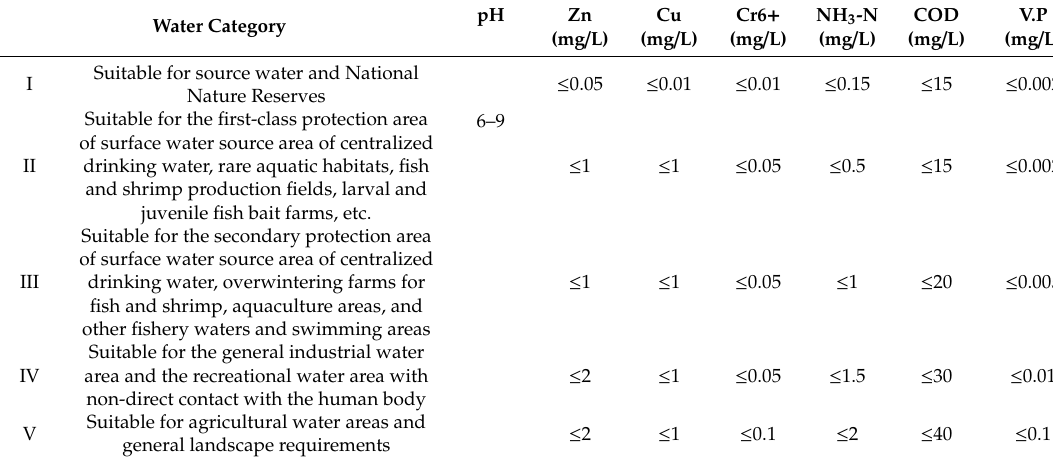
Table 3. Surface water quality index scale (GB3838-2002).